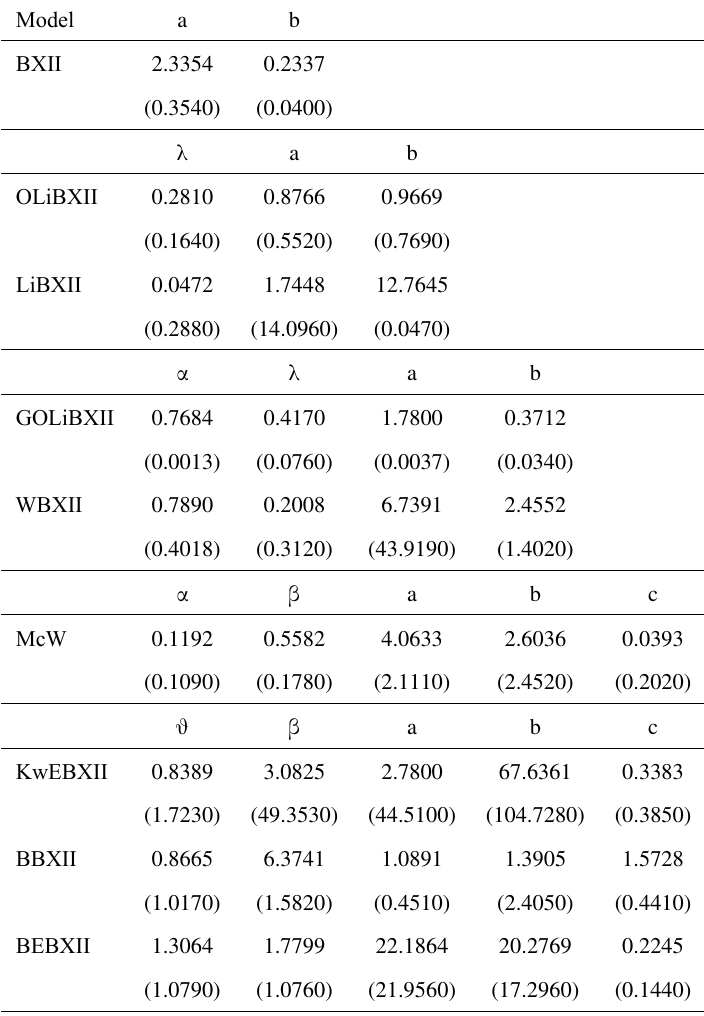
MLEs and their standard errors (in parentheses) for cancer